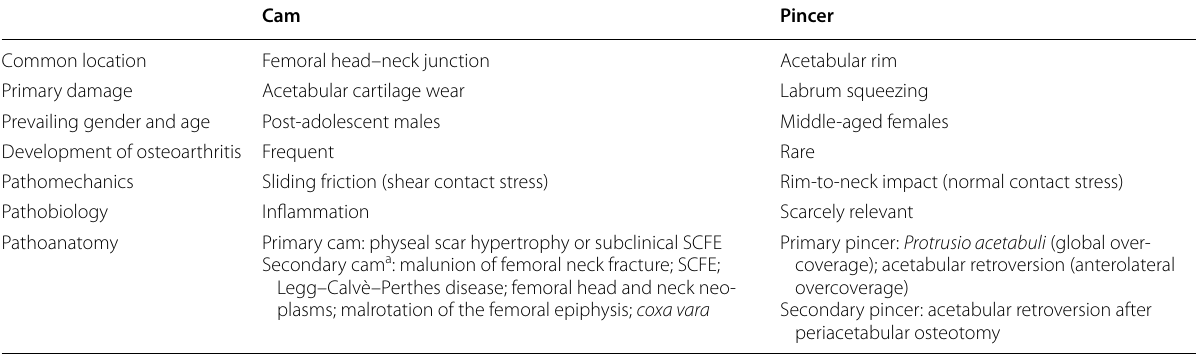
Table 1 Cam and pincer, similarities and